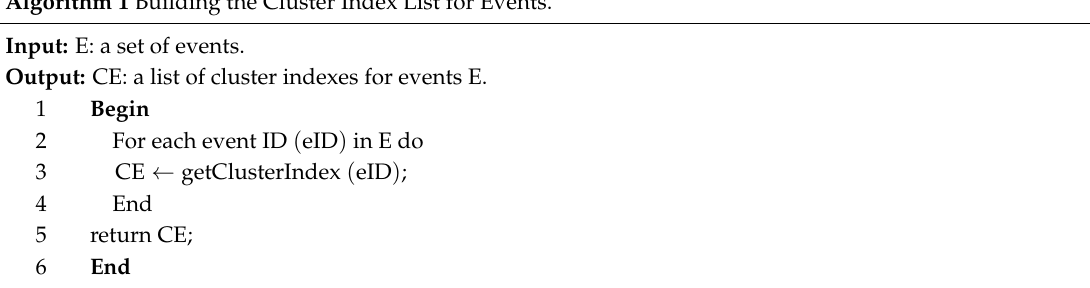
Algorithm 2 Finding Event Clusters that Intersect with a Given Subscription